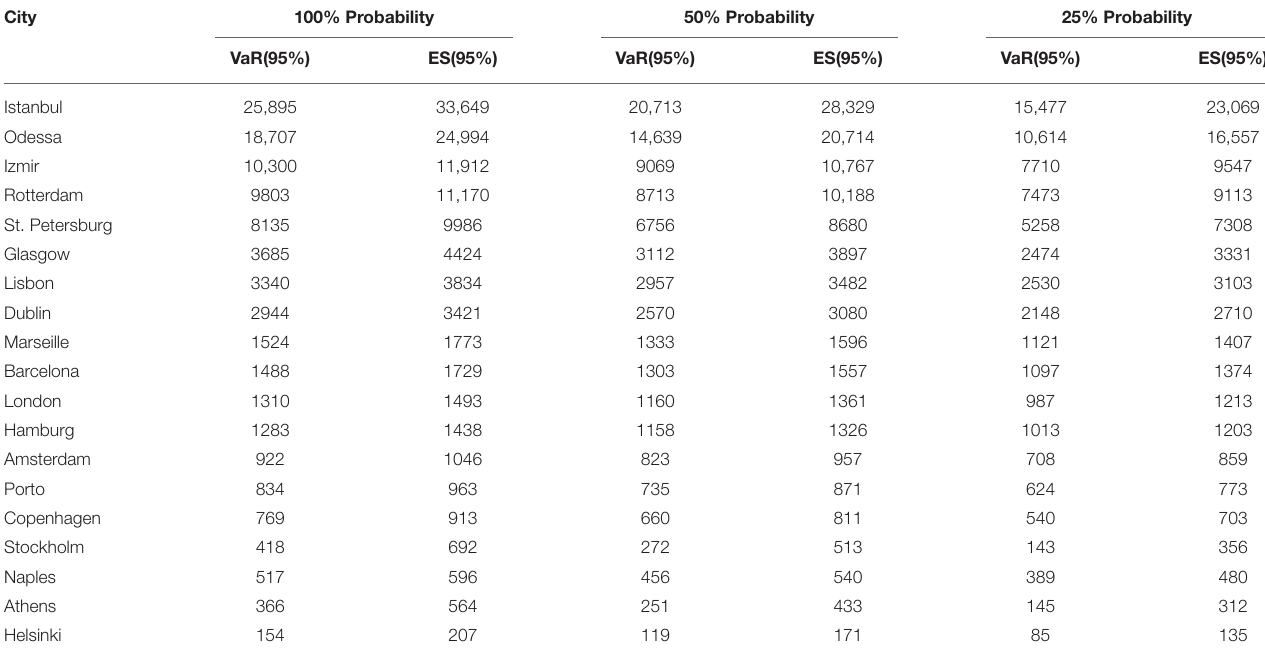
TABLE 7 | Losses in European cities for different probabilities of occurrence of RCP8.5 in 2100. City 100%